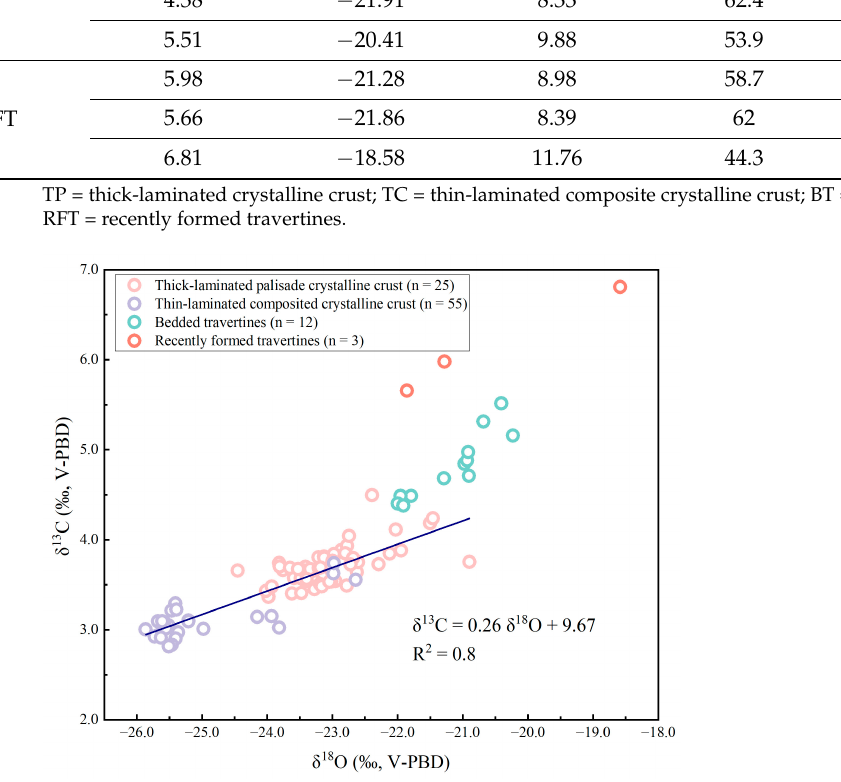
Figure 4. δ 13 C and δ 18 O of thick-laminated palisade crystalline crust, thin-laminated composite crystalline crust, bedded travertines and recently formed travertines at Xiagei. n = the number of samples. Bedded travertines from Xiagei show narrower δ 13 C and δ 18 O ranges compared to the fossil banded travertines (Table 2, Figure 5). They have δ 13 C values from 4.40‰ to 5.51‰ V-PDB (average = 4.82‰ V-PDB) and δ 18 O values from − 22.00‰ to − 20.23‰ V-PDB (average = − 21.17‰ V-PDB). δ 13 C values of recently formed travertines from Xiagei are from 5.66‰ to 6.81‰ V-PDB (average = 6.15‰ V-PDB), slightly higher that δ 13 C of the banded travertines. Comparatively, δ 13 O of the recently formed travertines from Xiagei is more negative than that of the banded travertines and varies from − 21.86‰ to − 18.58‰ V-PDB (average = − 20.57‰